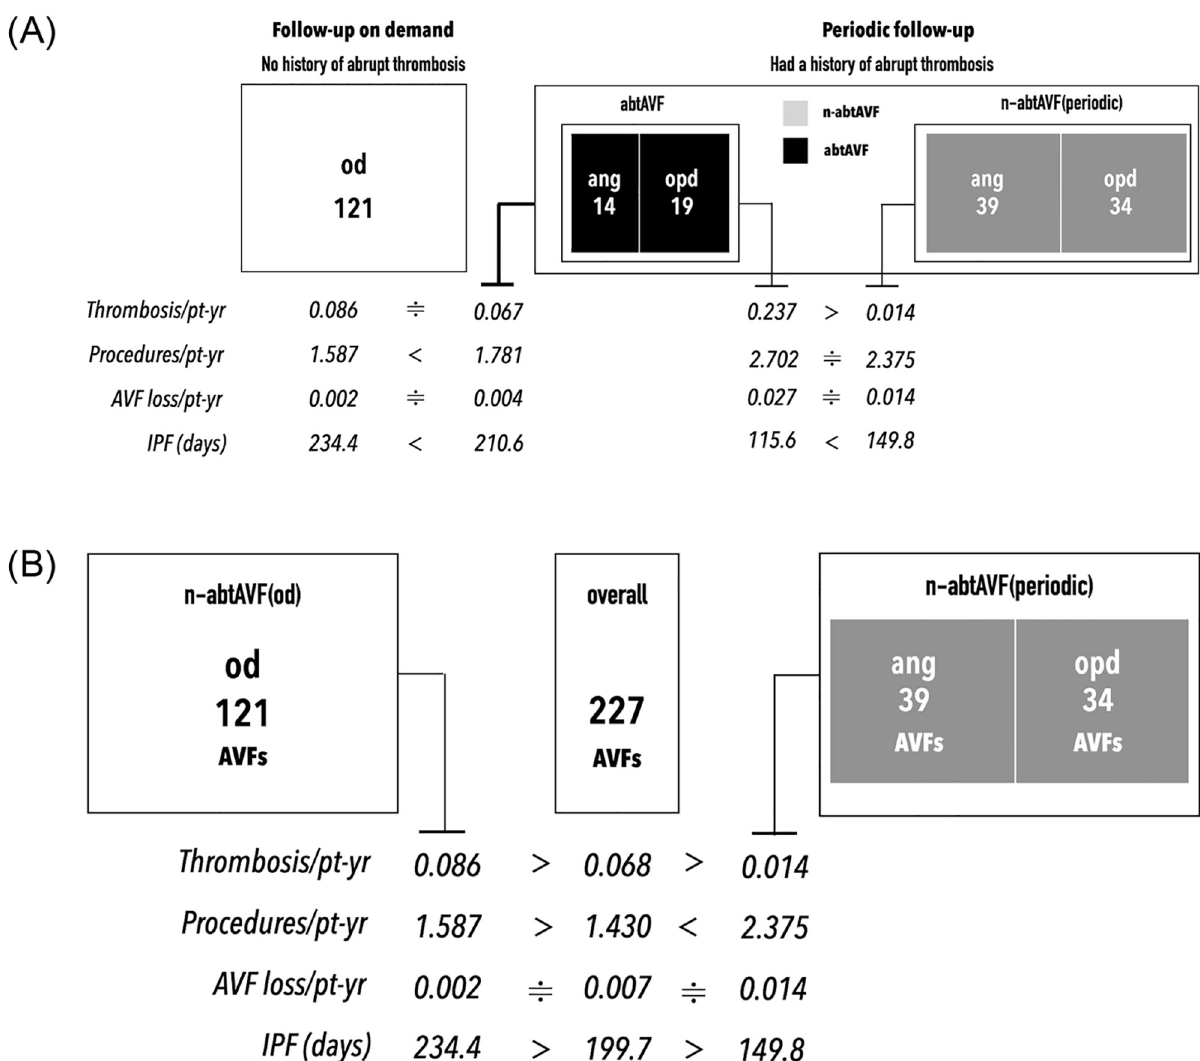
Fig 6. Comparison of the outcome measures between target follow-up groups. (A) Outcome measures of the abtAVF group and other target follow- up groups. Mathematical symbols: A > B or A < B imply that the value of A is statistically different from B; A ≑ B implies that the values of A and B were not statistically different. The thrombosis rate was highest in the abtAVF group and lowest in the n-abtAVF(periodic) group. There was no statistical difference in procedure rates between the two groups, indicating that the abtAVF group had a relatively faster restenosis rate than the n-abtAVF (periodic) group. (B) Comparison of the outcome measures between n-abtAVF(od)) vs. n-abtAVF(periodic). Mathematical symbols: A > B or A < B imply that the value of A is statistically different from B; A ≑ B implies that the values of A and B were not statistically different. For AVFs without a history of abrupt thrombosis, under periodic surveillance yielded a significantly lower thrombosis rate than that under on-demand